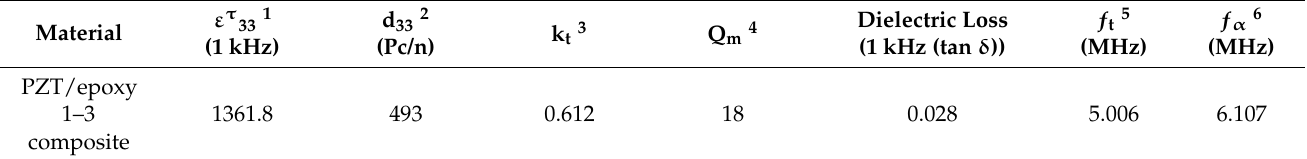
Figure 2. ( a ) The configuration of the transducer. The blue dotted box is a close-up of the transducer; ( b ) The photograph of the ring-array transducer.